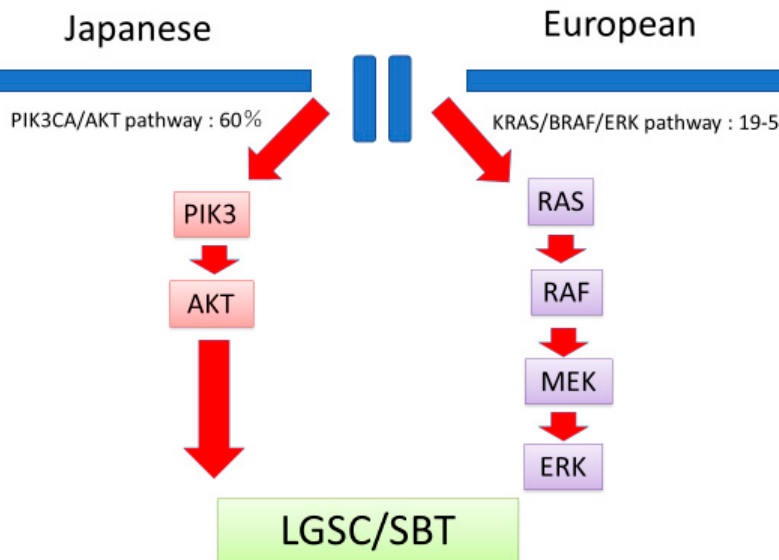
Figure 4. Hypothesized differences in carcinogenesis between Japanese and European patients with LGSC. LGSC in Japanese patients may depend on alterations in the PIK3CA/AKT pathway, whereas in Europeans it may depend on alterations in the KRAS/BRAF/AKT pathway.